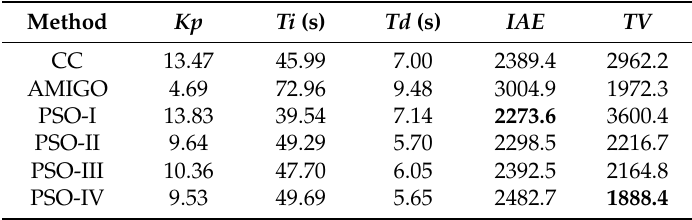
Table 3. TCLab physical results obtained for the several methods considering the entire test time. The best results are represented in bold.